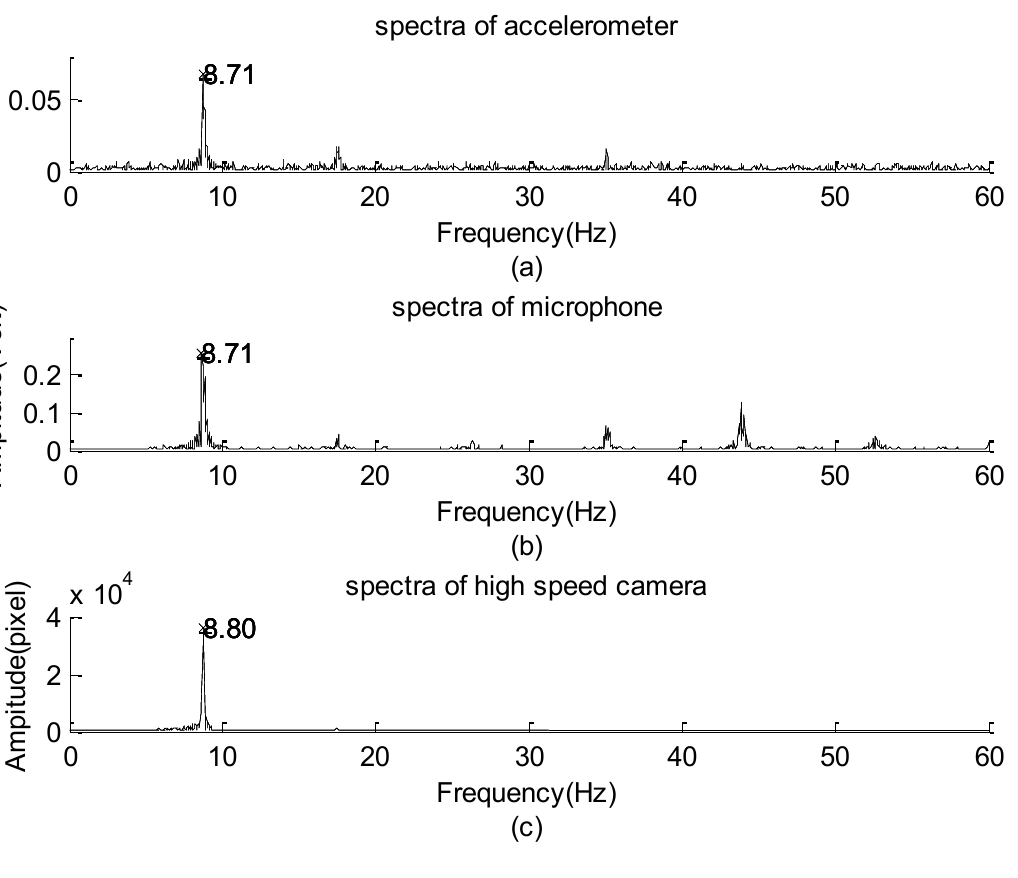
Figure 16. The wavelet coefficient plots log scale of the small helicopter in operation captured by: ( a ) accelerometer. ( b ) microphone. ( c ) high speed